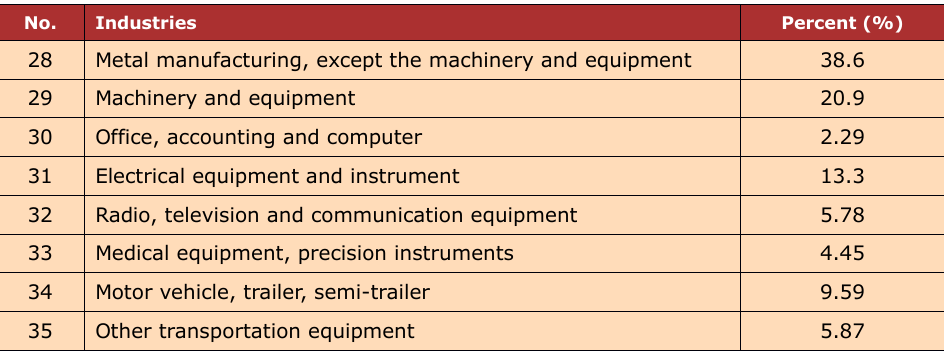
Table 1. The samples of industries distribution